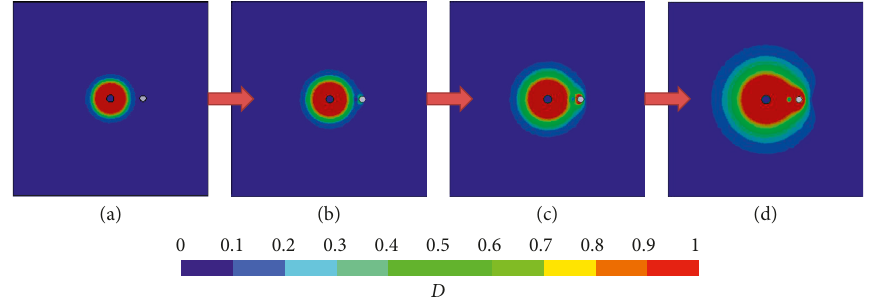
Figure 5: Damage evolution process of the model 1. (a) t � 11.971 μ s, (b) t � 13.991 μ s, (c) t � 17.47 μ s, and (d) t � 24.482 μ s.